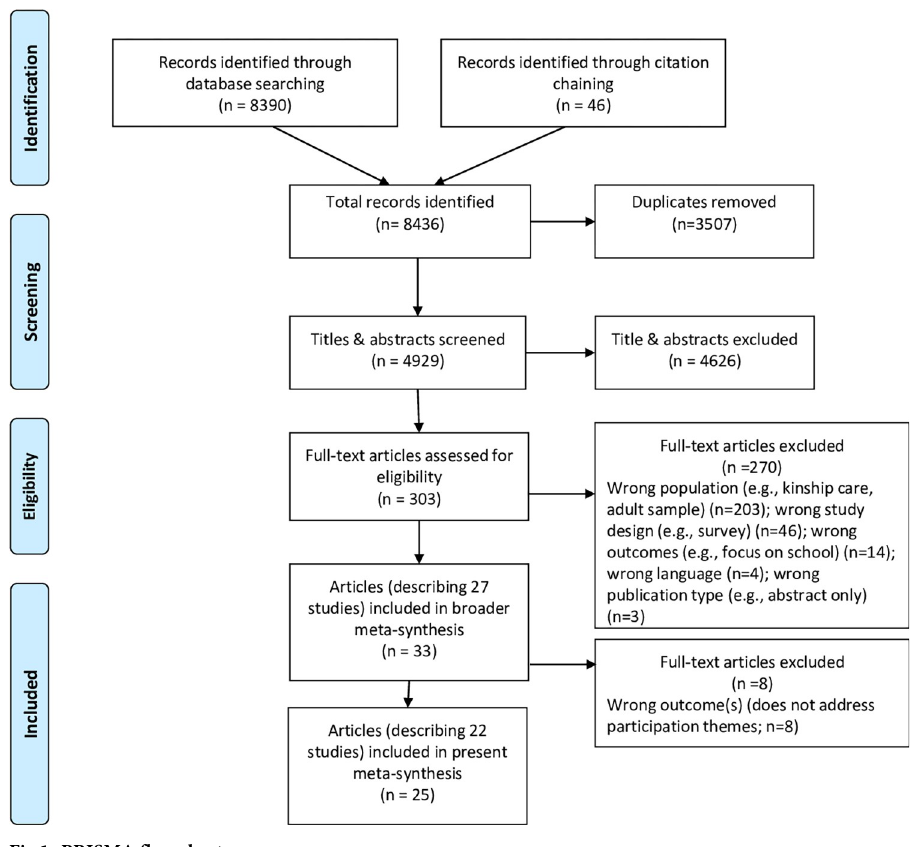
Fig 1. PRISMA flow